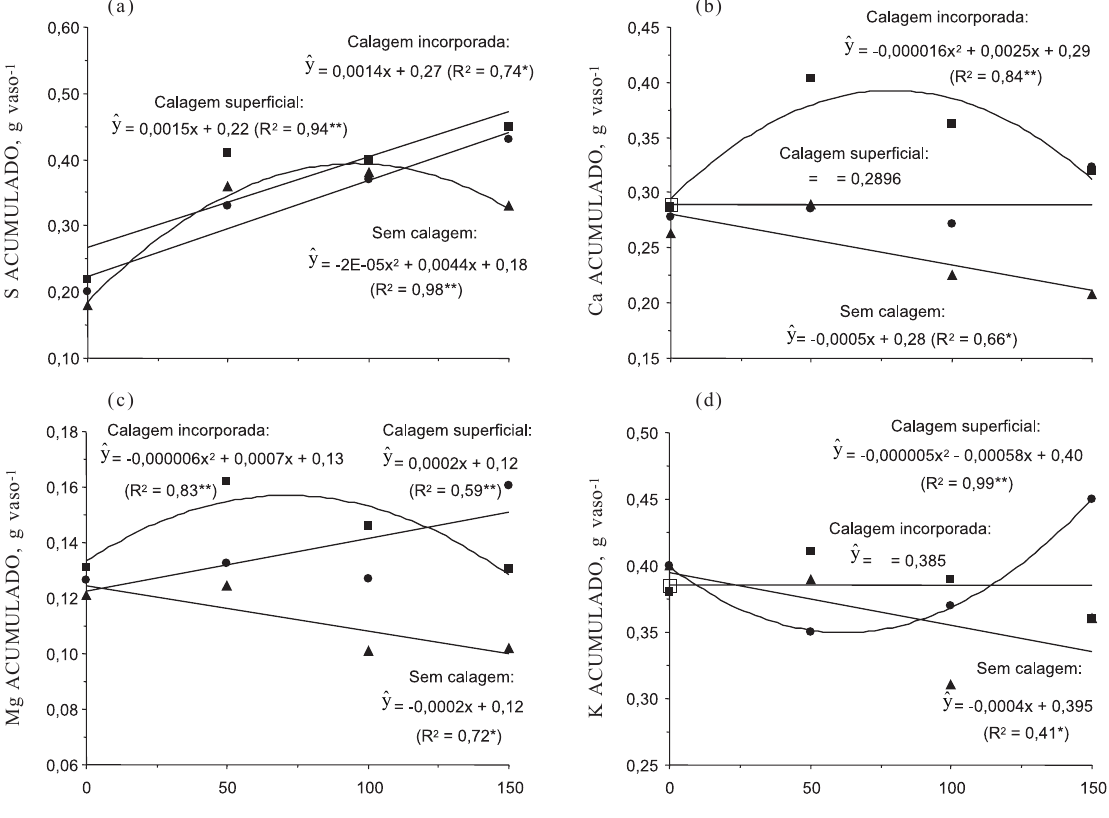
Figura 3. Acúmulo de enxofre (a), cálcio (b), magnésio (c) e potássio (d) na parte aérea das plantas de algodão, em função das doses de N aplicadas em cobertura, nas condições de calagem superficial ( ), calagem incorporada ( ) e sem calagem ( ). * e ** significativos a 5 e 1 %, respectivamente. ns: não-